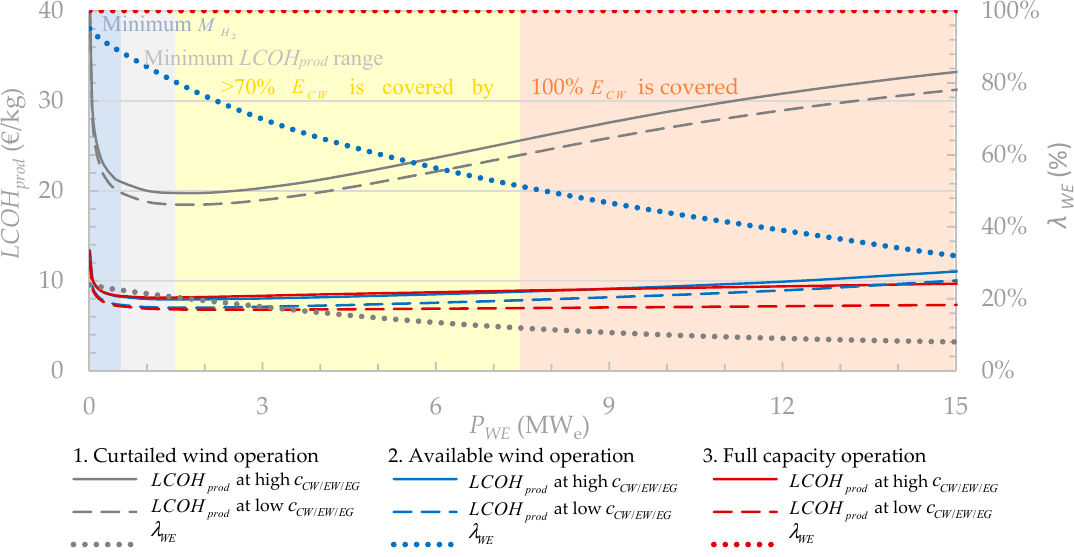
Figure 6. Calculated LCOH prod for Ballincollig Hill wind farm as a function of electrolyser size for all operation scenarios.